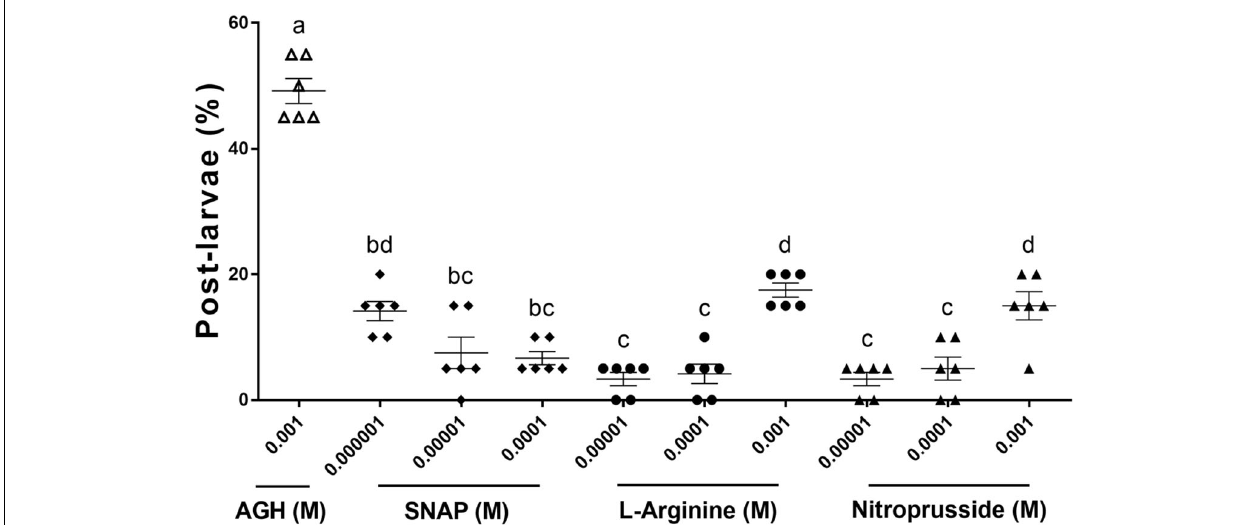
FIGURE 2 | Effect of NO donors on the metamorphosis of M. coruscus larvae. Larvae were exposed to NO donors S-nitroso- N -acetyl- DL -penicillamine (SNAP) (A) , L -arginine (B) , and sodium nitroprusside (SNP) (C) for 15 min and then inhibited by AGH for 24 h, and the metamorphosis rate of larvae was measured at 96 h posttreatment with NO donors. Data are shown as mean ± SEM ( n = 20), and bars with different letters are significantly different. All bioassays were performed at 17 ± 1 ◦ C in the dark with six